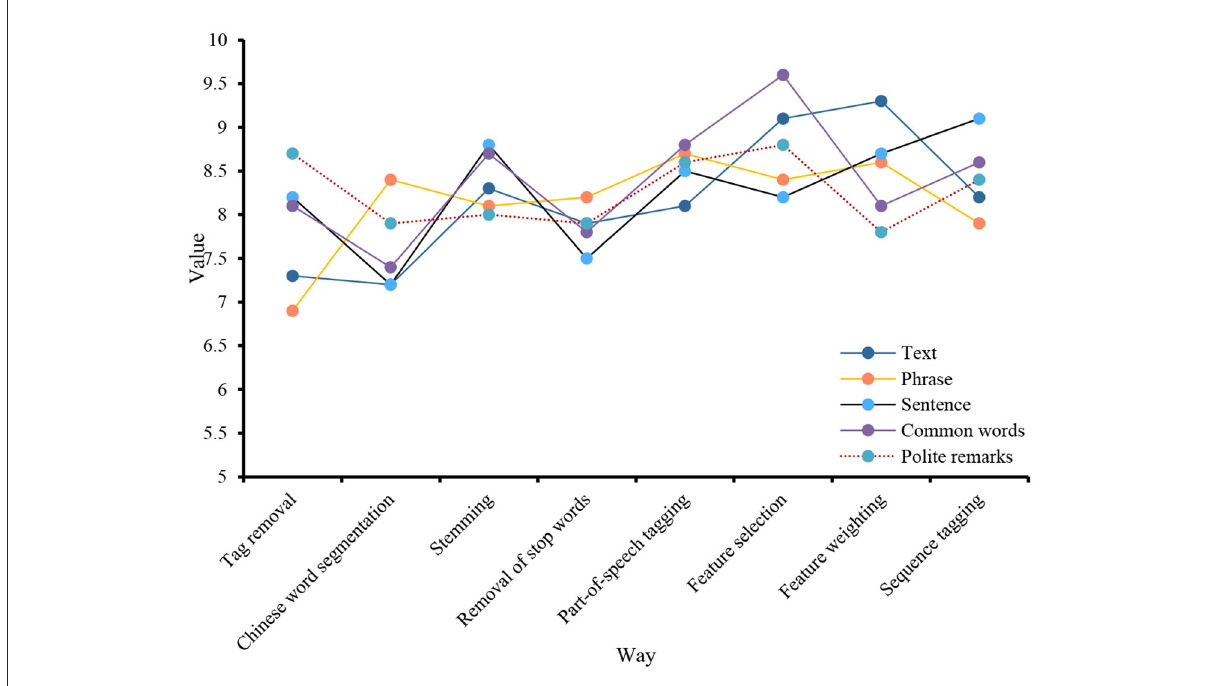
FIGURE6 Translation process.